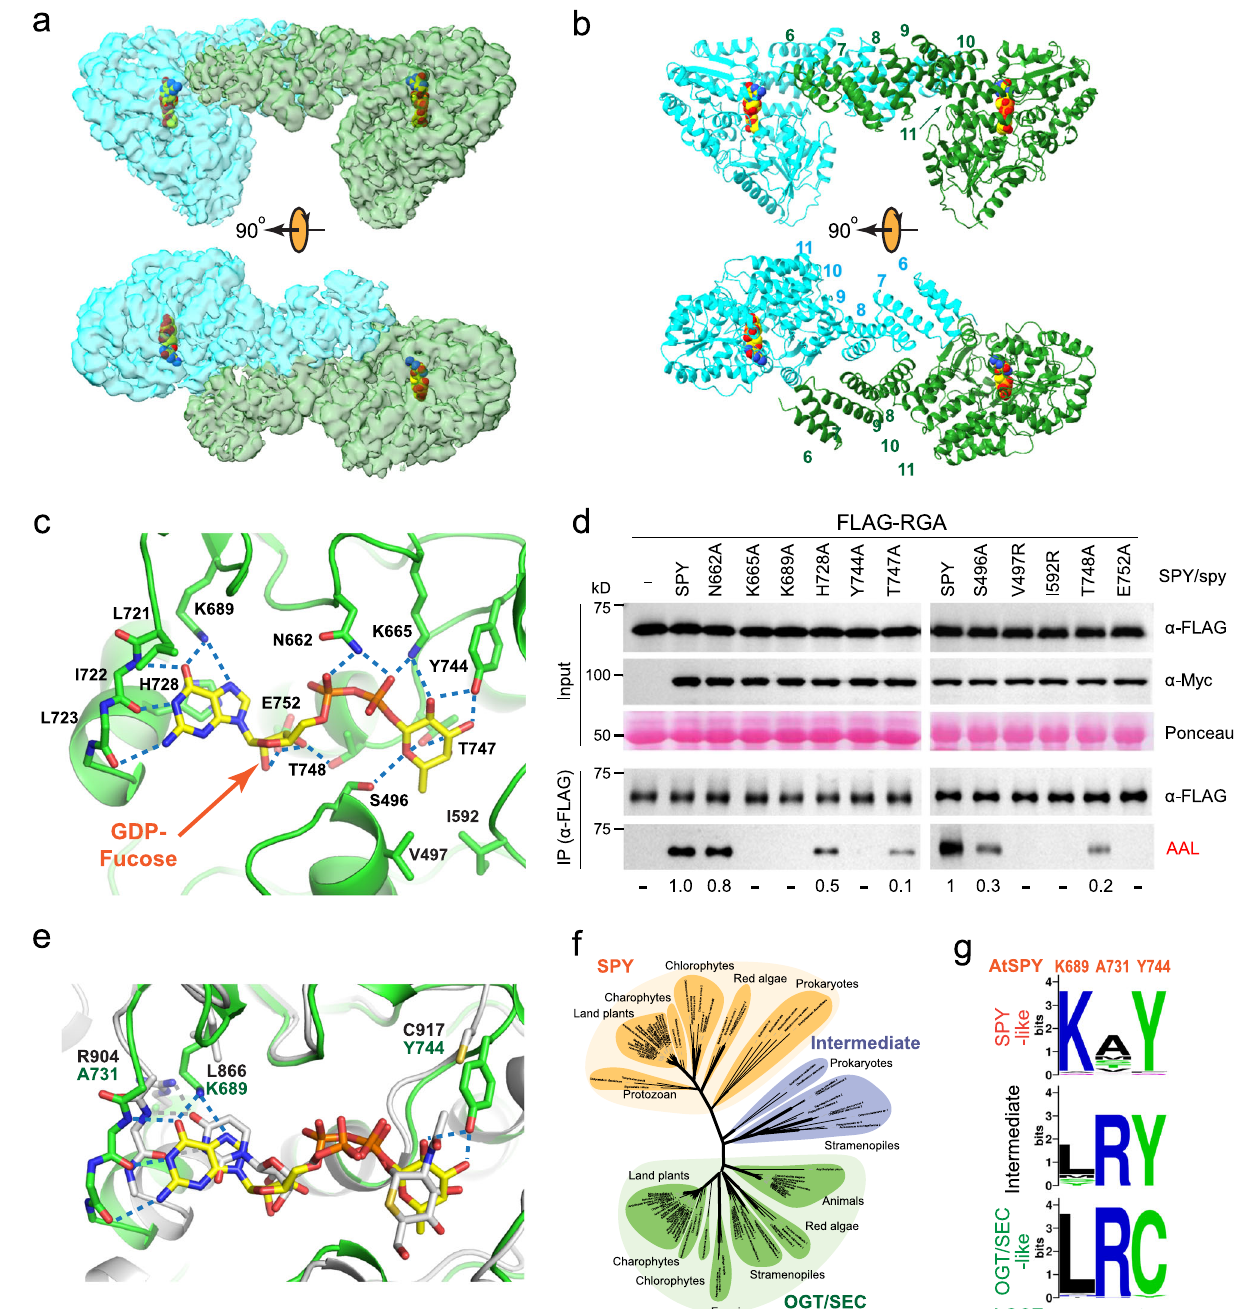
Fig.2|GDP-fucoserecognitionbySPY. Cryo-EMmapandcartoonrepresentation ofSPYincomplexwithGDP-fucoseareshowninpanels( a )and( b ),respectively. c A zoomed-in view of the GDP-fucose recognition by SPY with interfacial residues labeled. Hydrogen bonds are denoted by dashed lines. d Effects of active site mutations on the catalytic activity of SPY in planta. FLAG-RGA proteins were expressed alone ( − ) or co-expressed with Myc-SPY or spy mutant proteins in N. benthamiana . Top panel (Input): Immunoblots containing total protein extracts. Bottom panel ( α -FLAG IP ’ ed samples): Immunoblots containing af fi nity-puri fi ed